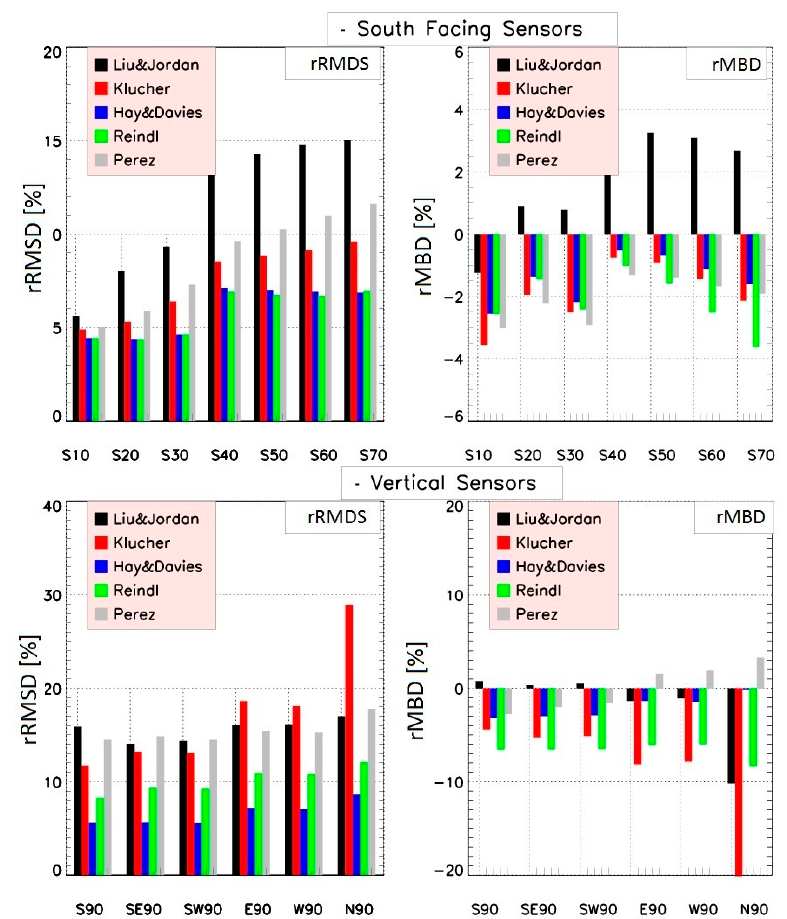
Figure 8. Root mean square difference ( left ) and mean bias difference ( right ) between model and measurements at IMUK for all south facing sensors (upper plots) and vertical sensors (lower plots). The difference increases, as the tilt angle increase.